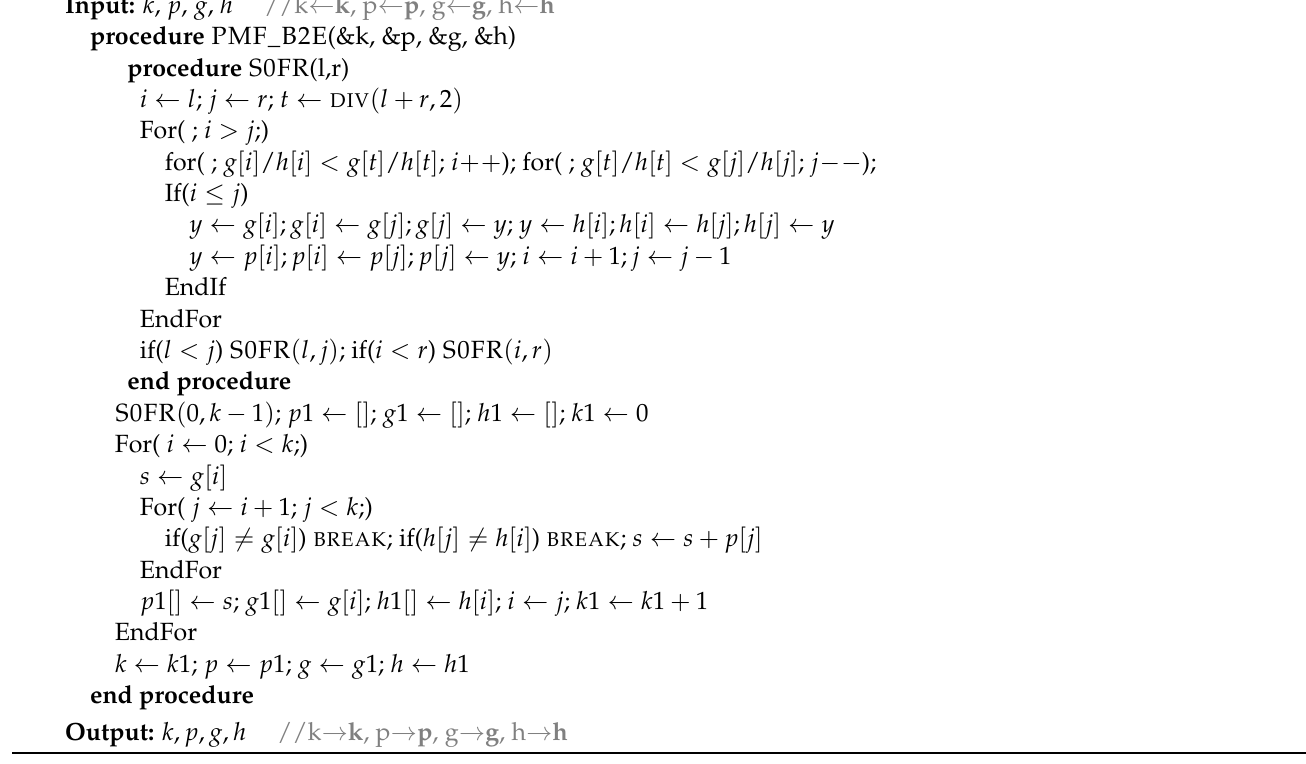
Algorithm 4: PMF for bivariate binomial expressions (B2E), Equation (15).